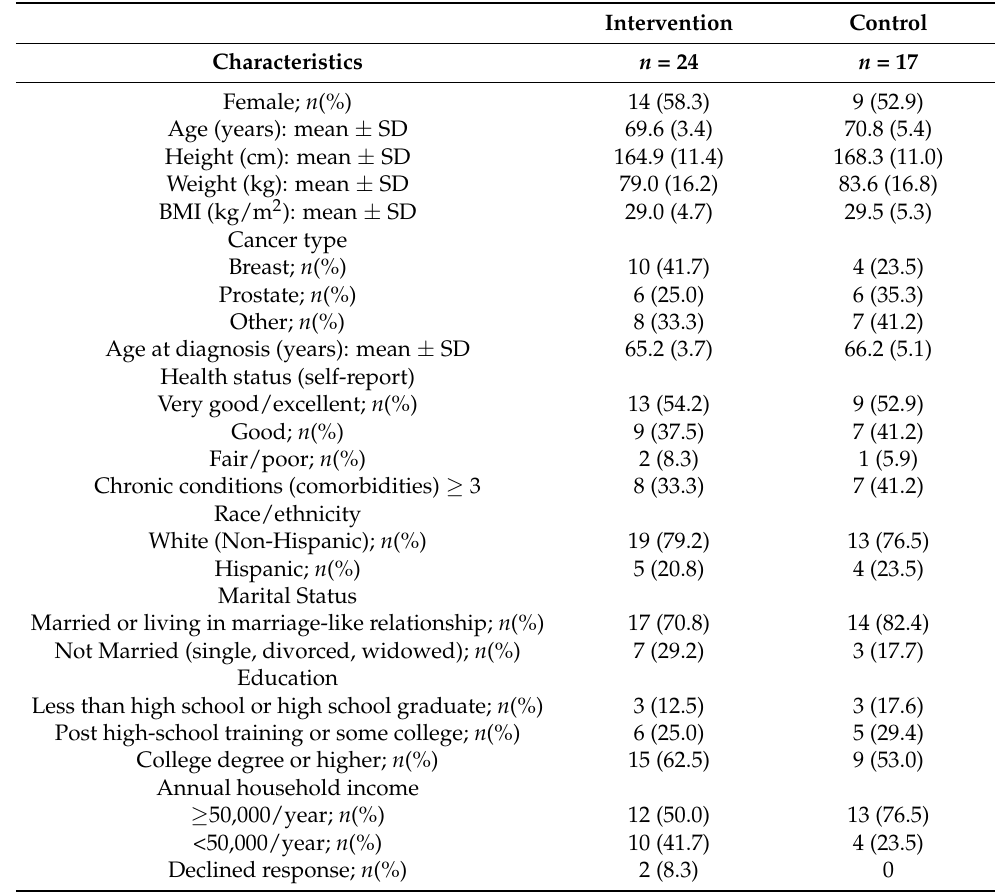
Table 1. Baseline participant